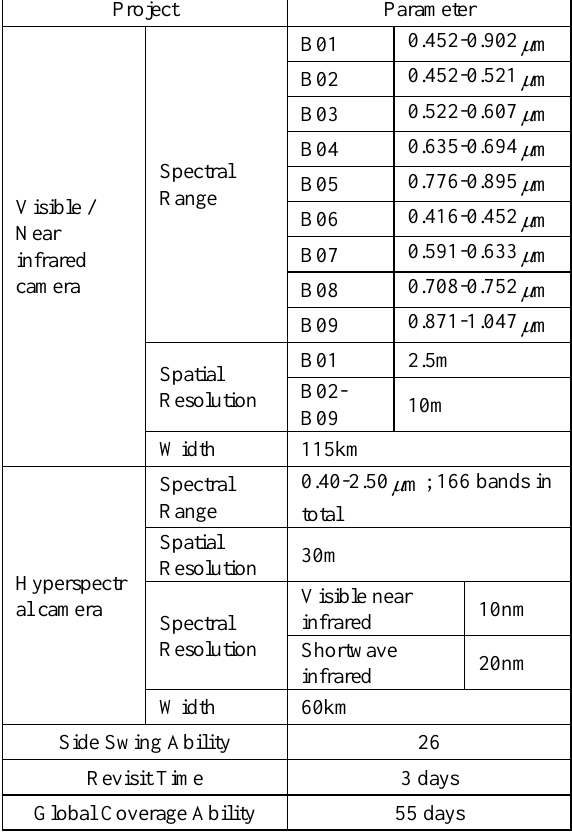
Table 1 . Parameters of ZY1-02D